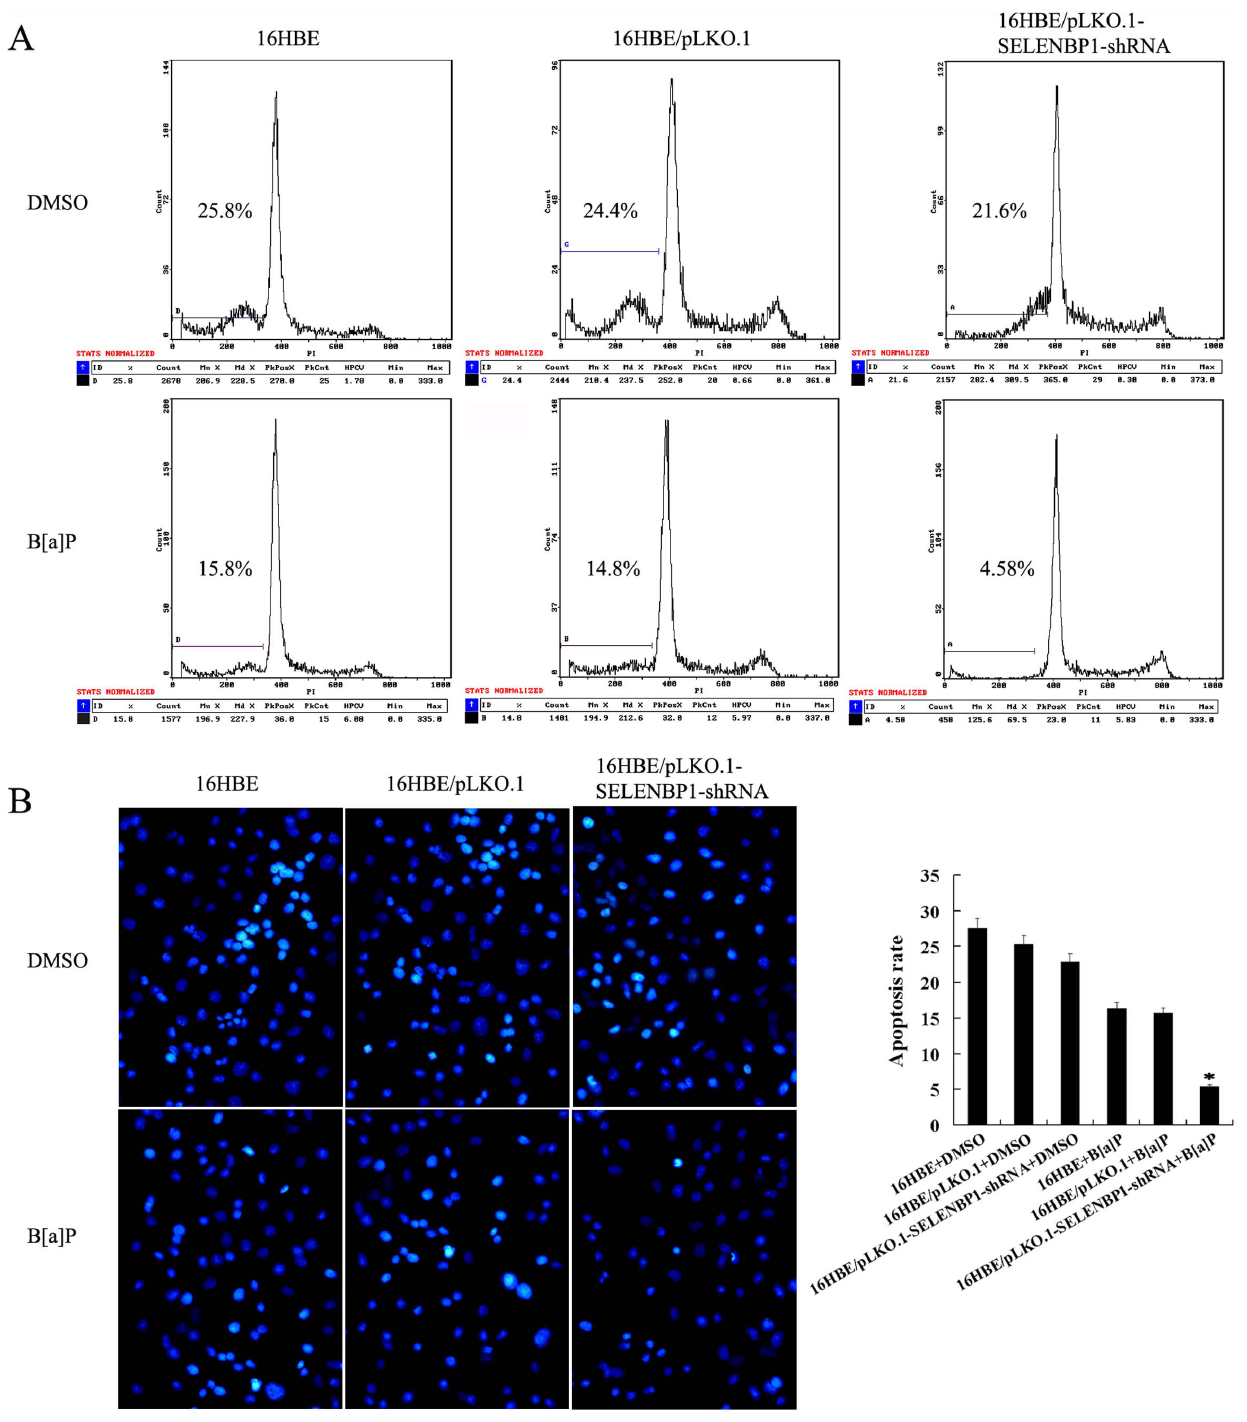
Figure 4. The effects of SELENBP1 knockdown on the apoptosis of B[a]P-transformed human bronchial epithelial cells. A, a representative result of flow cytometry analysis of cell apoptosis cultured in serum free medium after exposed to B[a]P for 18 weeks. Cells were grown in serum free DMEM medium for 24 h, and then assessed for apoptosis by flow cytometry as described in ‘‘Materials and Methods’’. B, ( right ) Hoechst 33258 staining of cell apoptosis cultured in serum free medium after exposed to B[a]P for 18 weeks. Cells were grown in serum free DMEM medium for 24 h, and then assessed for apoptosis using the cell-permeable DNA dye Hoechst 33258. Apoptotic nuclei showing intense fluorescence corresponding to chromatin condensation; ( left ) a histogram showed the cell apoptotic rates. Three experiments were done; columns, mean; bars, S.D.(*, P , 0.05 vs. untransfected or empty vector -transfected 16HBE cells exposed to B[a]P). Apoptosis of the cells exposed to vehicle (DMSO) for 18 weeks is also shown and used as controls. 16HBE, untransfected cells; 16HBE/pLKO.1, empty vector pLKO.1-transfected cells; 16HBE/pLKO.1- SELENBP1-shRNA, pLKO.1-SELENBP1-shRNA-tansfected cells.